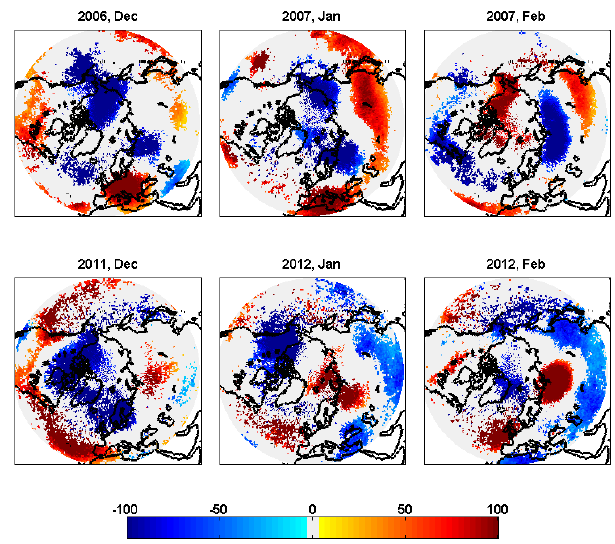
Fig. 2. Geopotential height anomalies [m] for the DJF months of Fig. 2: Geopotential height anomalies [m] for the DJF months of 2006/07 (top row) and 2006/07 (top row) and 2011/12 (bottom row). The regions with 2011/12 (bottom row). The regions with anomalies less than one standard deviation masked out. anomalies less than one standard deviation masked